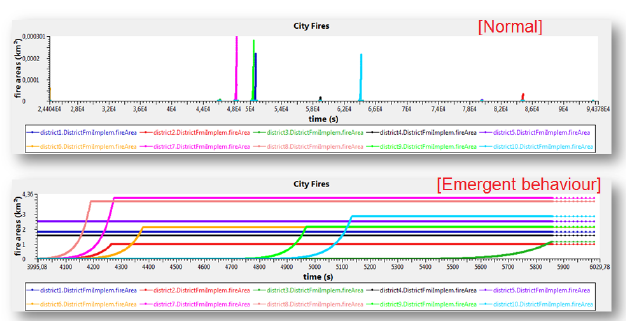
Figure 11. Simulation results in